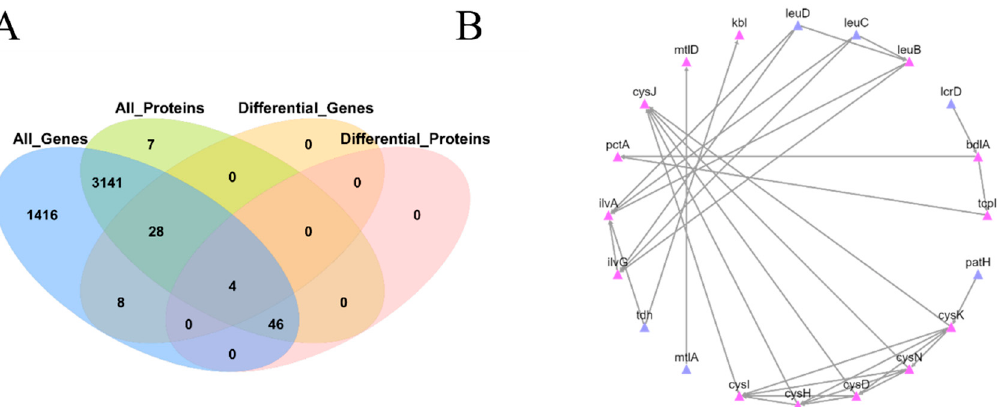
Figure 6. ( A ) Venn diagram of differentially expressed genes (DEGs) and differentially expressed proteins (DEPs) between wildtype and gcvB knockout strains; ( B ) PPI network of the identified DEPs (STRING score > 700). These genes showed consistent changes in gene expression with the shape of the lactation curve. The genes located at key nodes were also listed in supplementary Table S4.